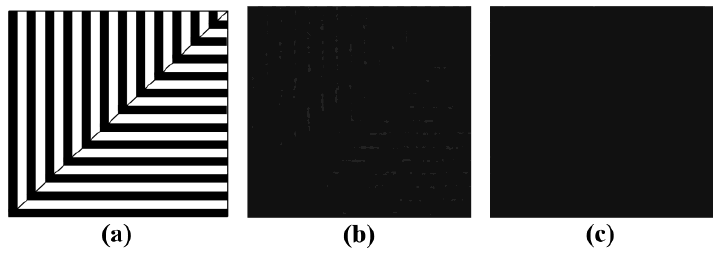
Figure 3. Result of correspondence of DMD-to-CCD. ( a ) Gating pattern taken by DMD camera; ( b ) Not corresponding; ( c ) Corresponding.